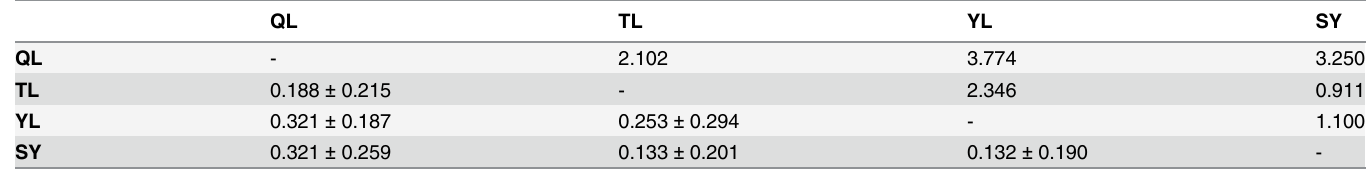
Table 4. Average pairwise Fst and its standard deviation (below diagonal), and the net genetic distance between the populations based on the seven nuclear genes (above